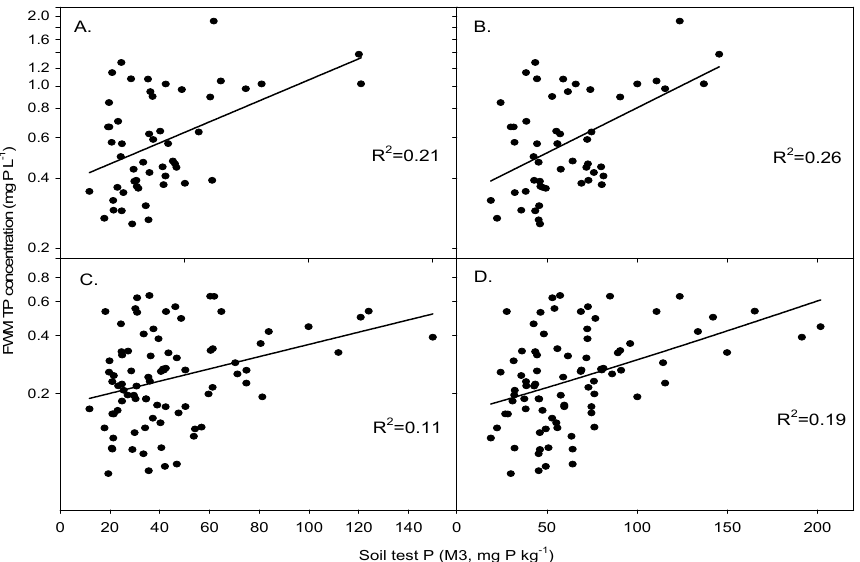
Figure 2. Regression relationships between soil test P (STP) and flow weighted mean total P (FWM TP) concentrations (natural log transformed). Surface runoff FWM TP vs. STP for the ( A ) agronomic soil horizon (0–20 cm) and the ( B ) surface cm soil horizon (0–5 cm). Tile drainage FWM TP vs. STP for the ( C ) agronomic soil horizon and the ( D ) surface soil horizon. Regressions were performed on log transformed runoff P concentrations; data are plotted in original units with log-scale x-axis.